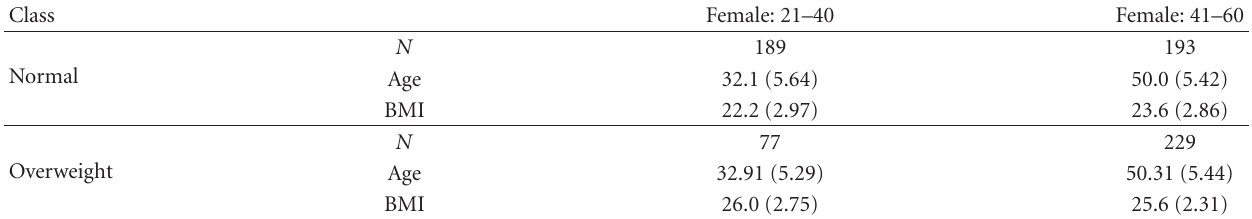
Figure 1: All points in a facial image for feature extraction ((a): points and areas in frontal image; (b): points in profile image; (c): points in right eye; (d): point in left eye). Distance, angle, and area measurements were done based on self-made tool using MATLAB on Window XP. Table 2: Subject characteristics and basic statistics (data are presented as mean (standard deviation); N : number of subjects, BMI: body mass